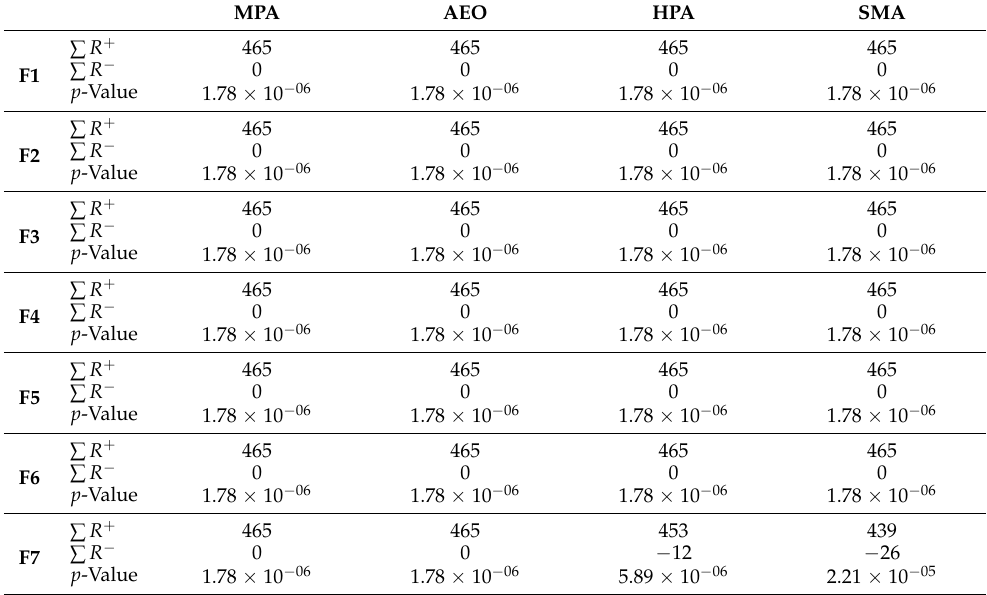
Table 5. Nonparametric test using WSRT values for unimodal benchmark functions.